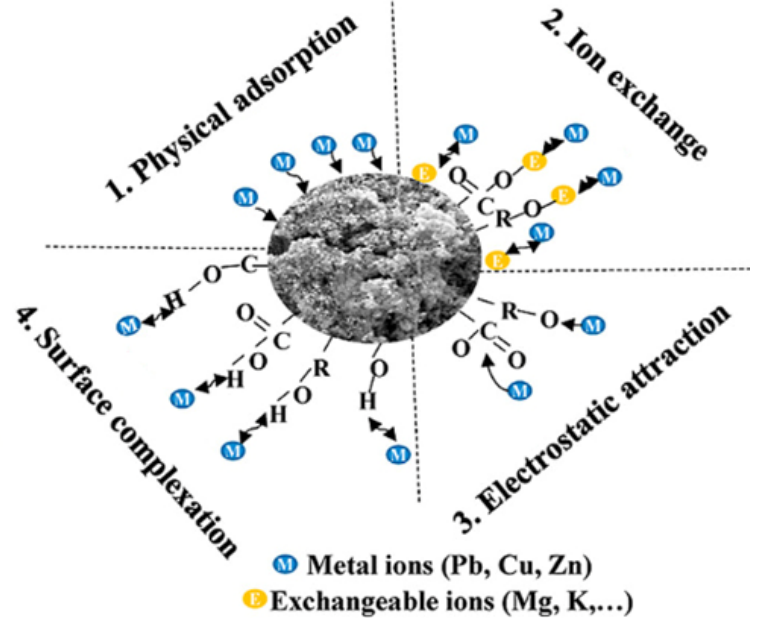
Figure 5. Schematic mechanism of metal ion adsorption by AC surface. Diagram adapted from [73].